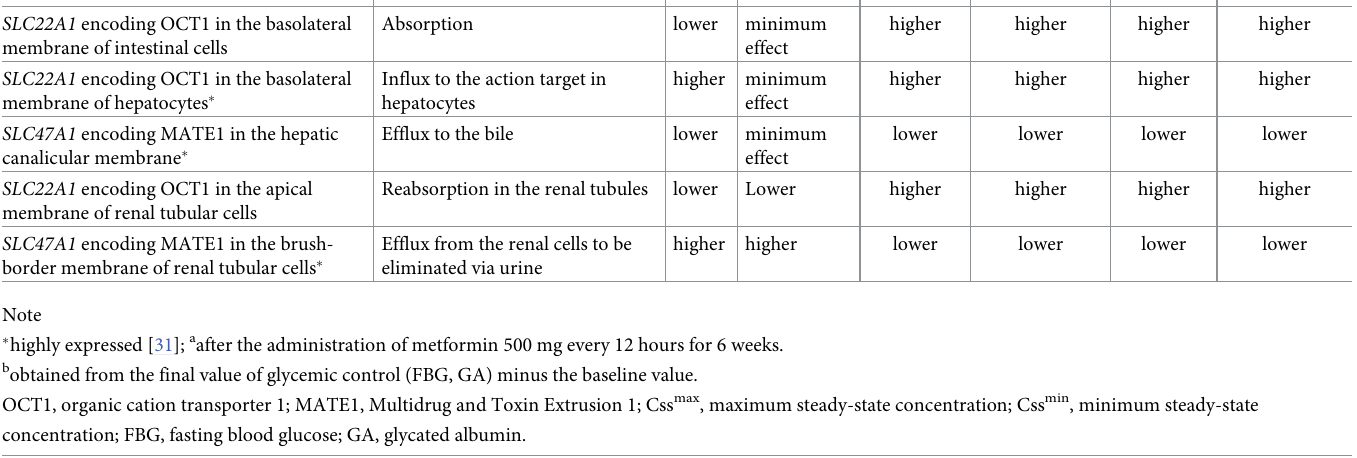
Table 2. Prediction of the steady-state pharmacokinetic variability and glycemic response affected by the genetic polymorphisms in SLC22A1 and SLC47A1 . Location of SNPs